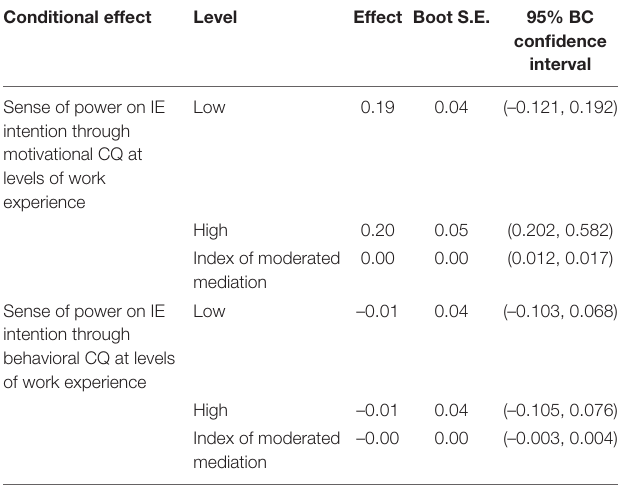
TABLE 4 | Conditional indirect effect process analysis.